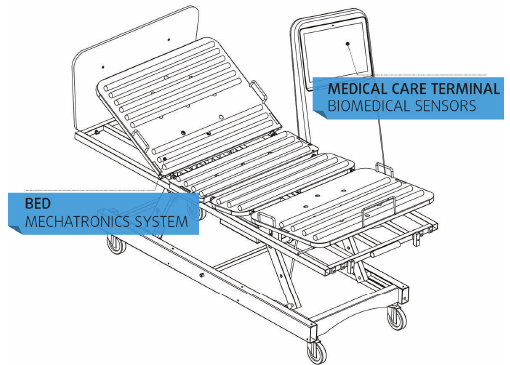
Figure 8: Bed with the MCT system [13,